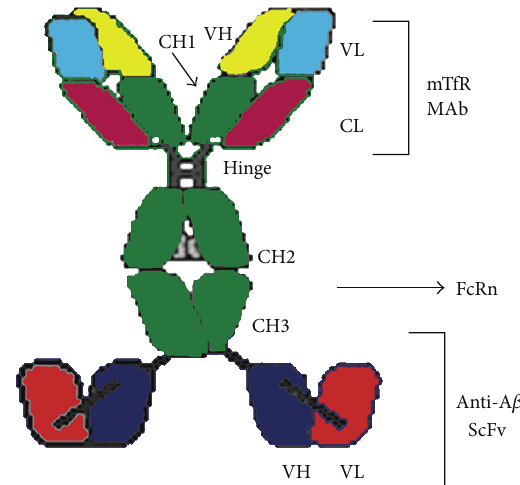
Figure 1: The cTfRMAb-ScFv fusion protein is formed by fusion of the variable region of the heavy chain (VH) of the rat 8D3 MAb against the mouse transferrin receptor (mTfR) (yellow) to the amino terminus of mouse IgG1 constant (C) region (green), and fusion of a single chain Fv (ScFv) antibody against the A amyloid peptide to the carboxyl terminus of the heavy chain C-region. The light chain is composed of the variable region of the light chain (VL) of the rat 8D3 MAb (light blue) and the mouse kappa light chain C-region (CL) (dark red). The heavy chain constant region is composed of 4 domains: CH1, hinge, CH2, and CH3. The CH2-CH3 interface is the binding site for the neonatal Fc receptor (FcRn). The ScFv is composed of the VH (dark blue) and the VL (light red) derived from the anti-AMAb (adapted from Figure 1,